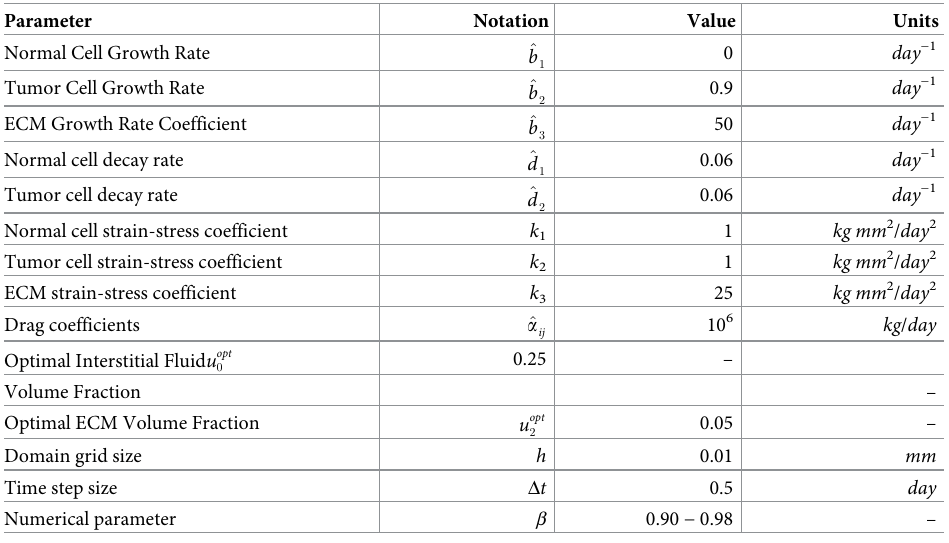
Table 3. Default parameter values and parameter ranges for the experiments in ECM deformation in tumorigenesis.